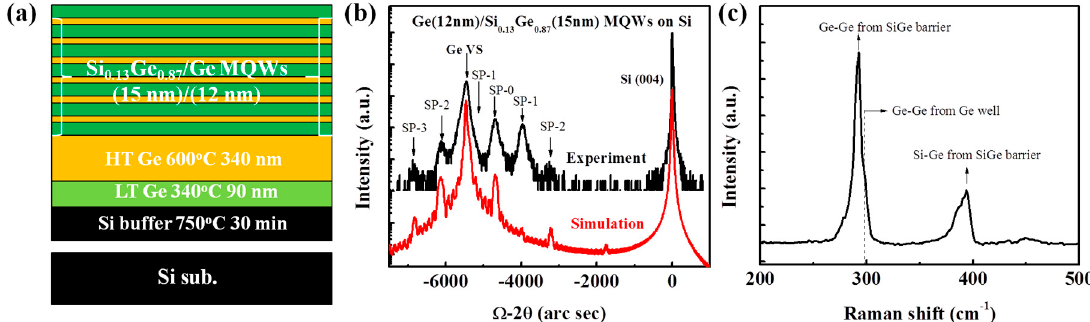
Figure 1. ( a ) Structure diagram for the SiGe/Ge MQWs grown on the Ge-on-Si substrate; ( b ) Corresponding (004) X-ray diffraction rocking curves; and ( c ) Raman spectrum. The strain in Ge wells and Si 0.13 Ge 0.87 barriers are 0.17% and 0.71%, respectively.